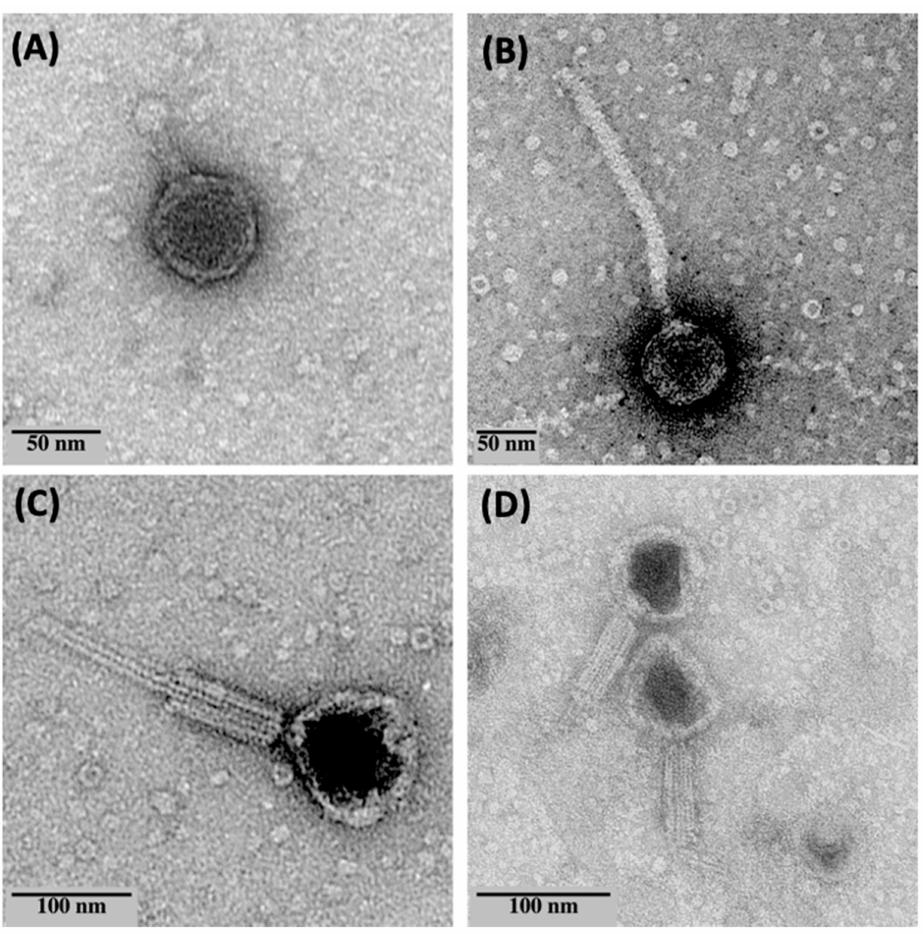
Figure 1. TEM micrographs of ( A ) Pseudomonas Phage_AUS034, ( B ) Pseudomonas Phage_AUS260, ( C ) Pseudomonas Phage_AUS301 and ( D ) Pseudomonas